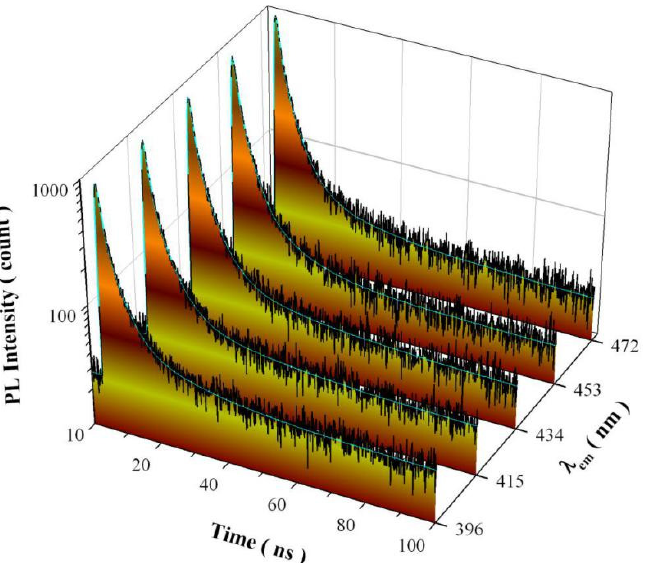
Figure 10. PL decay curves (black) and exponential reconvolution fits (cyan) of undoped SrAl 2 O 4 at different detection wavelengths. The excitation was the 320 nm pulsed light with a pulse period of 100 ns. Table 1. Exponential reconvolution fitting parameters of the PL decay curves of undoped SrAl 2 O 4 at different emission wavelengths ( λ em ). The excitation is the 320 nm pulsed light with a pulse period of 100 ns.